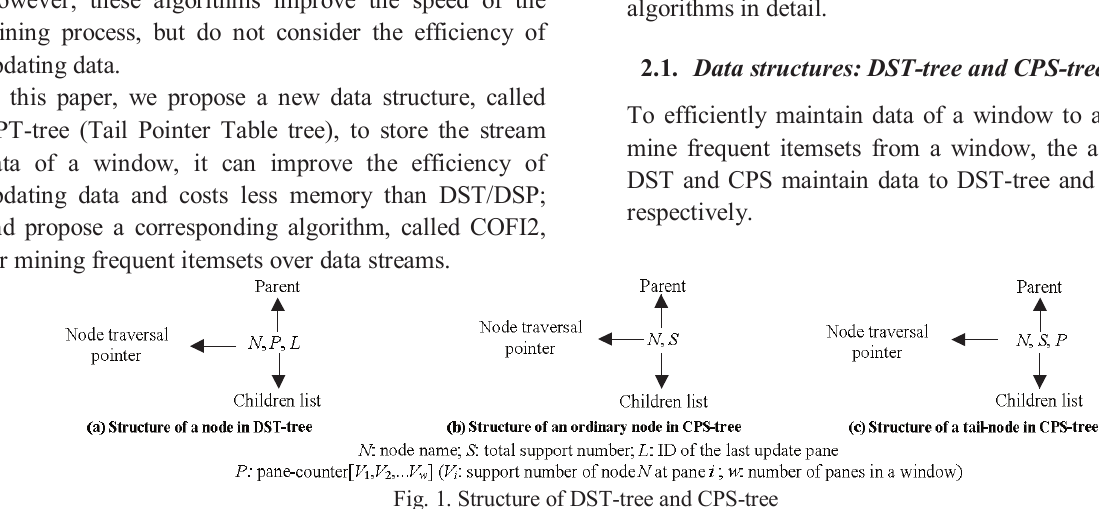
Fig. 1. Structure of DST-tree and